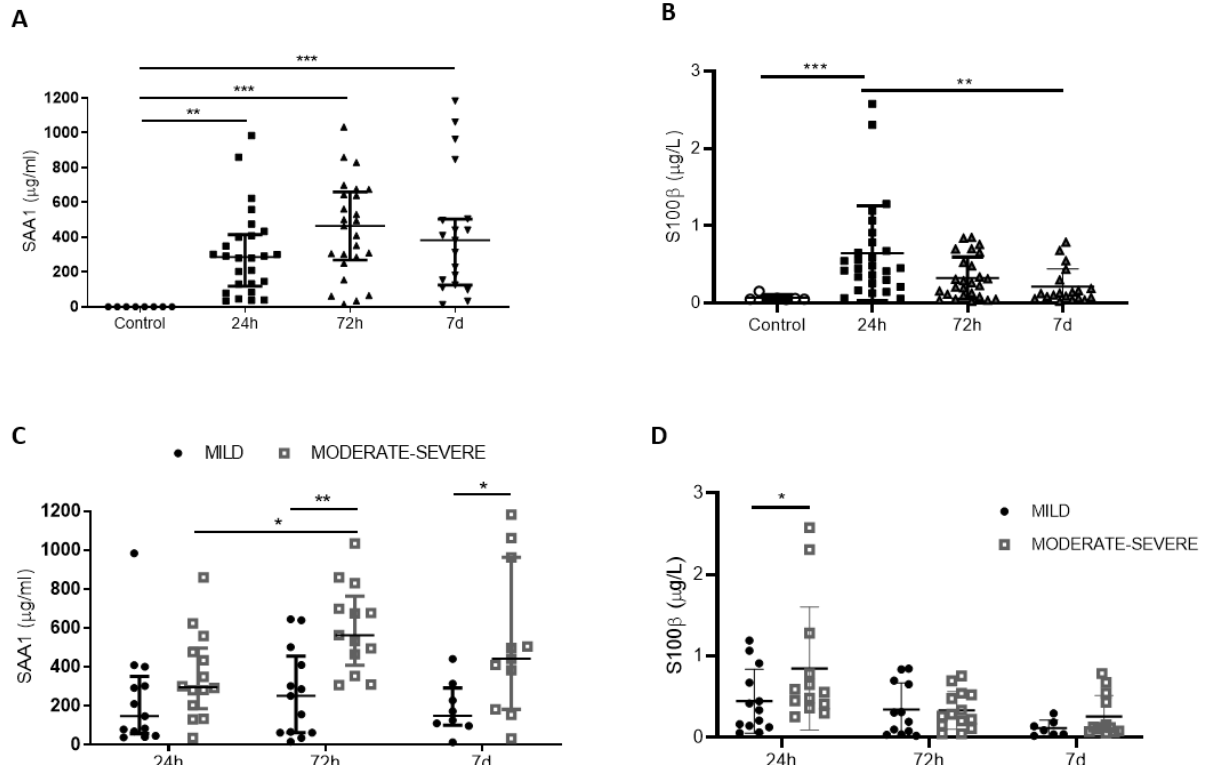
Figure 1. SAA1 levels remains increased the first week after trauma in serum of TBI patients, while S100B just raises at 24 h. ( A ) SAA1 levels increased at 24 h (n = 29), 72 h (n = 28), and 7 days (n = 21) after trauma compared to healthy subjects (controls, n = 8). ** p < 0.01, *** p < 0.001, Kruskal–Wallis with Dunn’s multiple comparisons test. ( B ) S100B levels significantly incremented at 24 h (n = 29), but not at 72 h (n = 28) and 7 days (n = 21) after trauma. ** p < 0.01, *** p < 0.001, Kruskal–Wallis with Dunn’s multiple comparisons test. ( C ) Patients were classified in two groups of severity (mild and moderate/severe) according to GCS. SAA1 serum levels correlated with severity at 72 h and 1 week post-trauma. * p < 0.05, ** p < 0.01, 2-way ANOVA with Sidak’s multiple comparisons test. ( D ) Patients were classified in two groups of severity (mild and moderate/severe) according to GCS. S100B levels correlated with severity at 24 h. * p < 0.05, 2-way ANOVA with Sidak’s multiple comparisons test. Data of all experiments are represented as median with interquartile range.